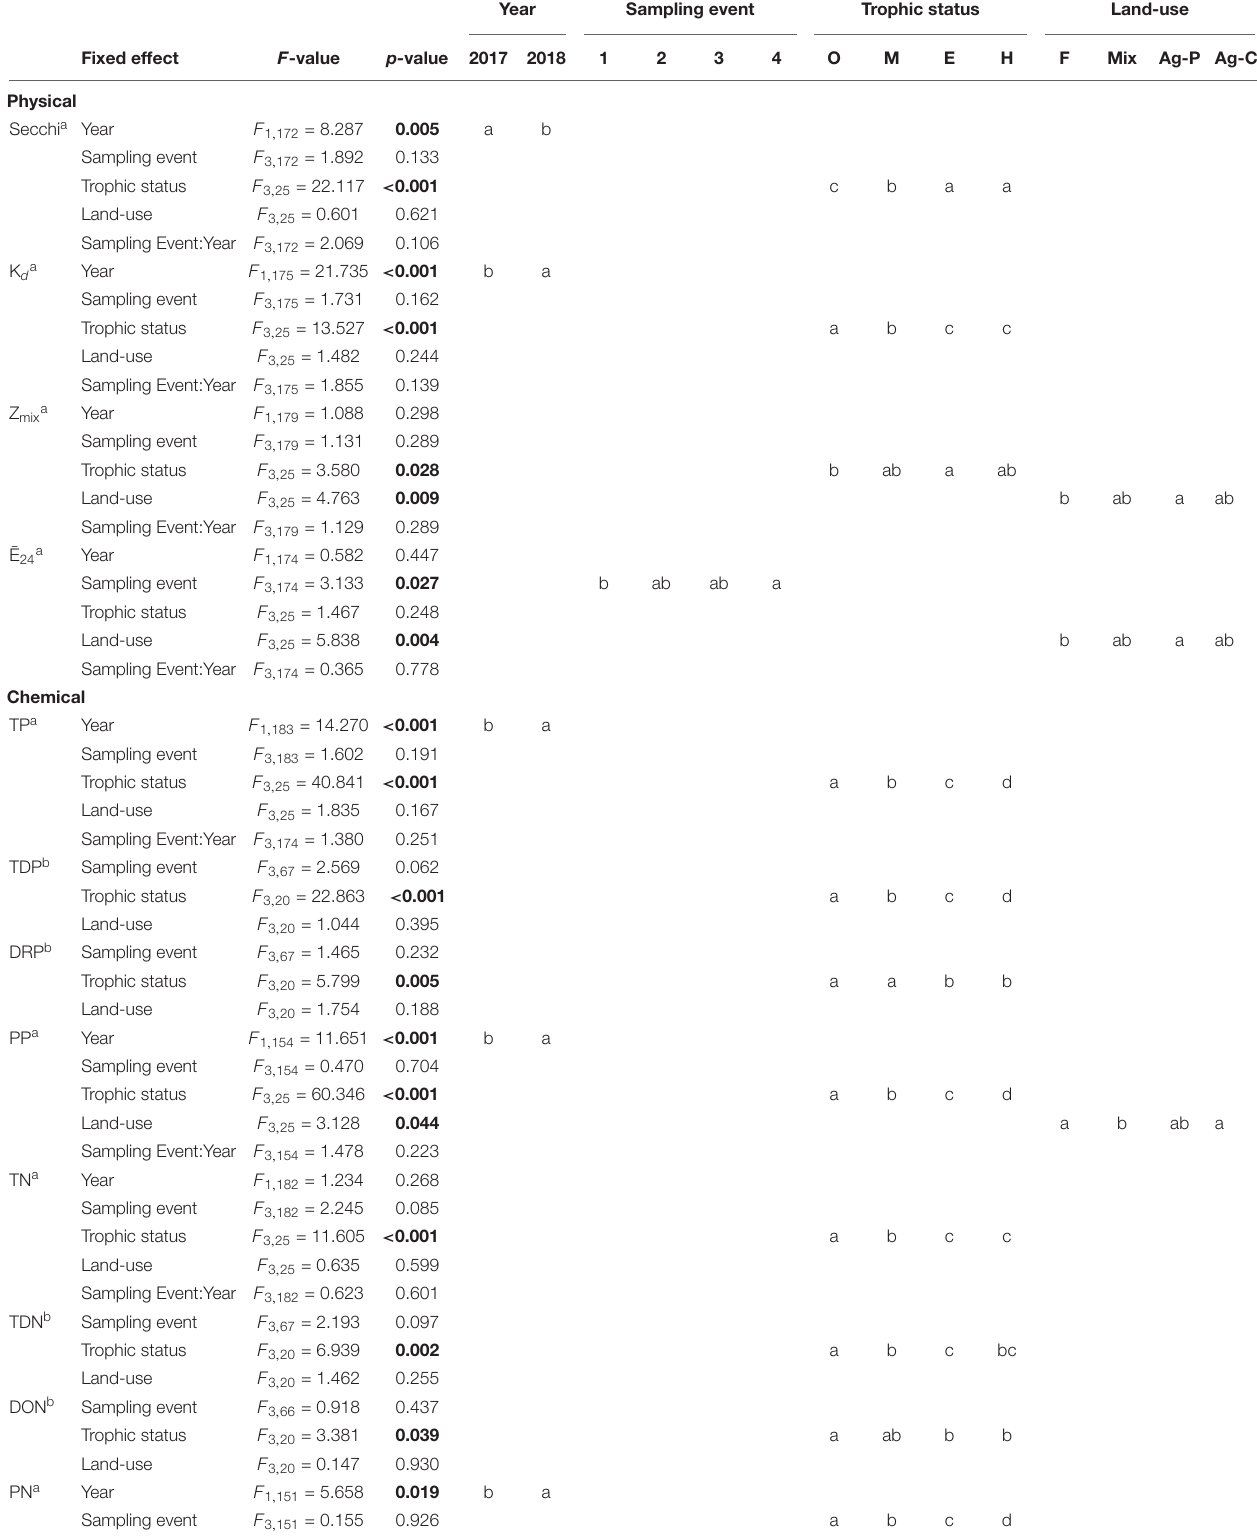
TABLE 5 | Linear mixed effect (LME) model output for physical, chemical, biological, nutrient status, and photosynthesis-irradiance (P-E) parameters. Year Sampling event Trophic status